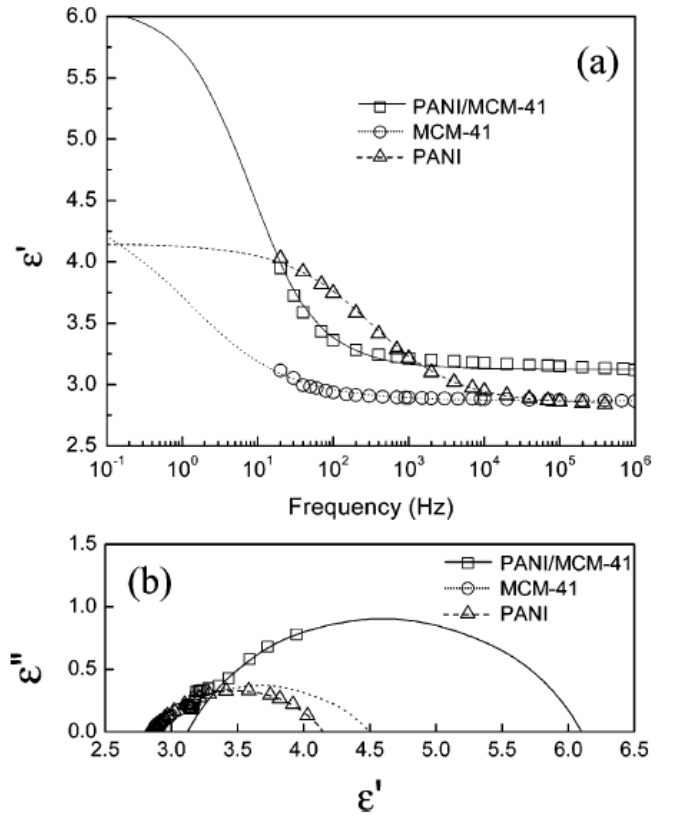
Figure 9. ( a ) Dielectric spectra (permittivity versus frequency); ( b ) Cole-Cole plot for each ER fluid (Reproduced with permission from [56]. Copyright American Chemical Society,